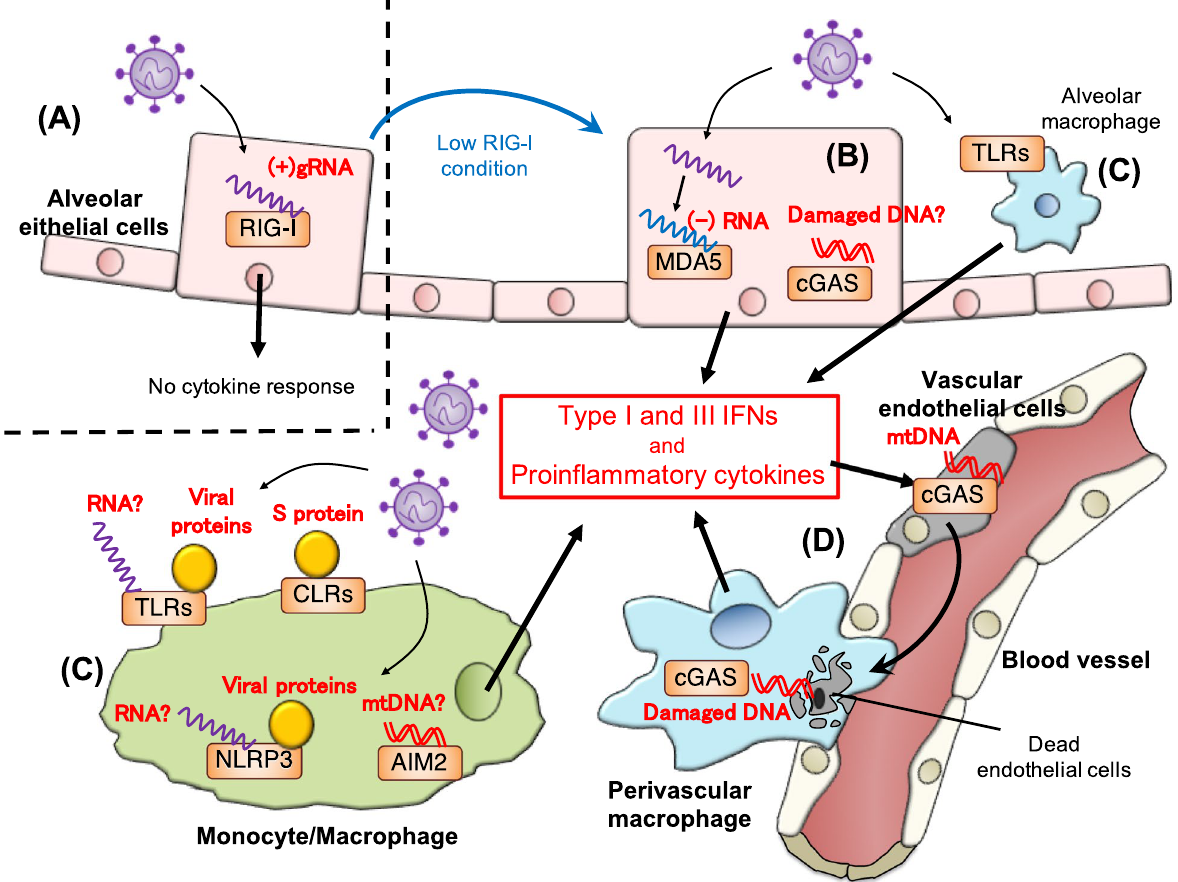
Fig. 2 Stepwise model of PRR-mediated activation of innate immune response in lung tissues during SARS-CoV-2 infection. In the first step, RIG-I senses ( )gRNA of SARS-CoV-2 that is released from a viral particle and directly inhibits viral replication without activation of the conventional + RIG-I downstream signaling A . In the condition of reduced RIG-I expression or in the epithelial cells with low/no levels of RIG-I expression, viral ( RNAs initiate to be transcribed from ( )gRNA by viral RdRp. Then, MDA5 in turn plays a role as an innate sensor to induce the expression of types I/ + III IFNs and proinflammatory cytokines. This signaling might result in cell damage, leading to activation of cGAS pathway via possibly the sensing of host nuclear or mitochondrial DNA B . In immune cells such as macrophages/monocytes, TLRs, CLRs, NLRP3, and AIM2 function as major innate sensors to recognize viral proteins, nucleic acids, and host DAMPs, resulting in innate cytokine responses C . These innate inflammatory responses induce the death of neighboring endothelial cells, leading to the activation of cGAS pathway via its mitochondrial DNA in the cells. The dead endothelial cells are engulfed by perivascular macrophages, and then the host damaged DNA activates cGAS pathway, which induces type I IFNs and proinflammatory cytokines D . This cGAS machinery may initiate a self-perpetuating loop of the sterile inflammation, causing the